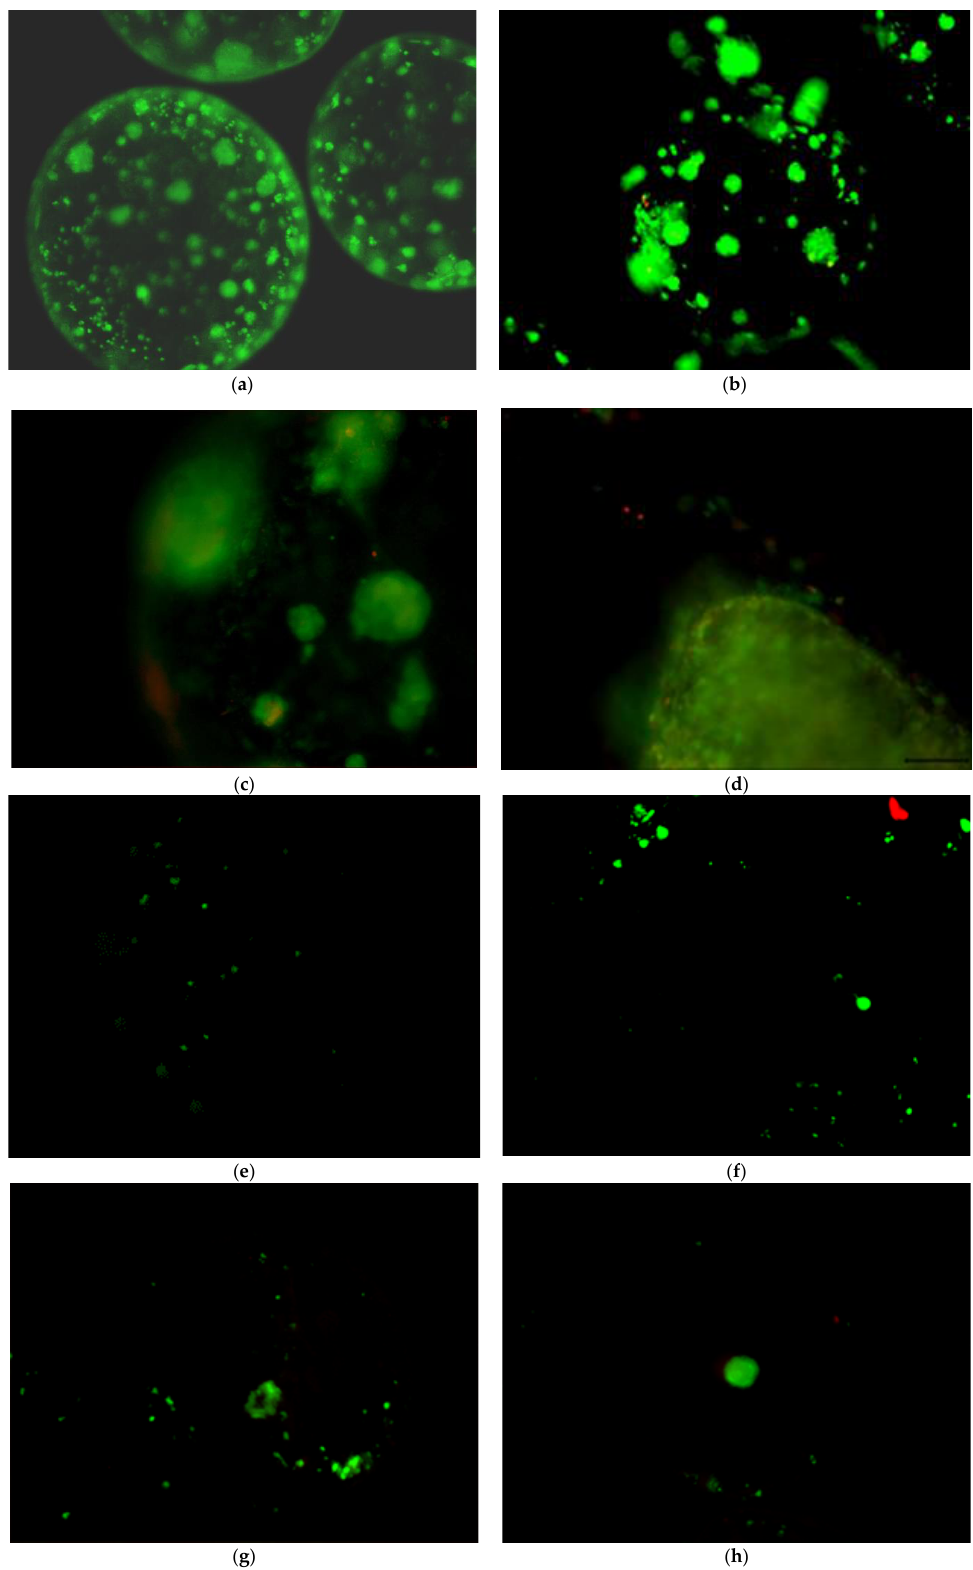
Figure 7. Brightfield images of 28-day chondrocyte and bMSC encapsulated cultures. ( a ) Chondro- cytes day 7; ( b ) chondrocytes day 14; ( c ) chondrocytes day 21; ( d ) chondrocytes day 28; ( e ) bMSC